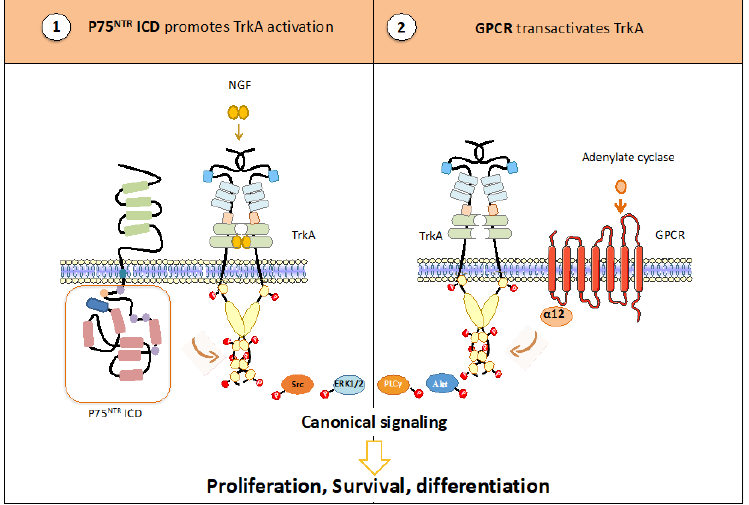
Figure 3. P75 NTR ( 1 ) and GPCR ( 2 ) promote the activation of TrkA via their intracellular parts. Following NGF stimulation, the intracellular part of P75 NTR is cleaved and promotes TrkA phosphorylation. In addition, GPCR transactivates TrkA in a ligand-independent-manner.